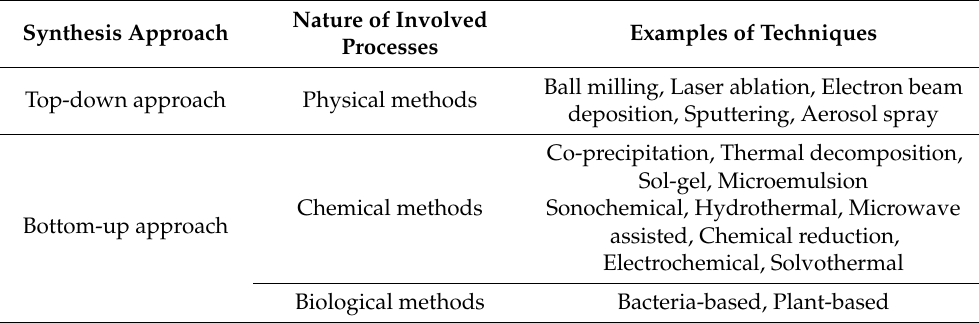
Table 1. Classification of NP synthesis